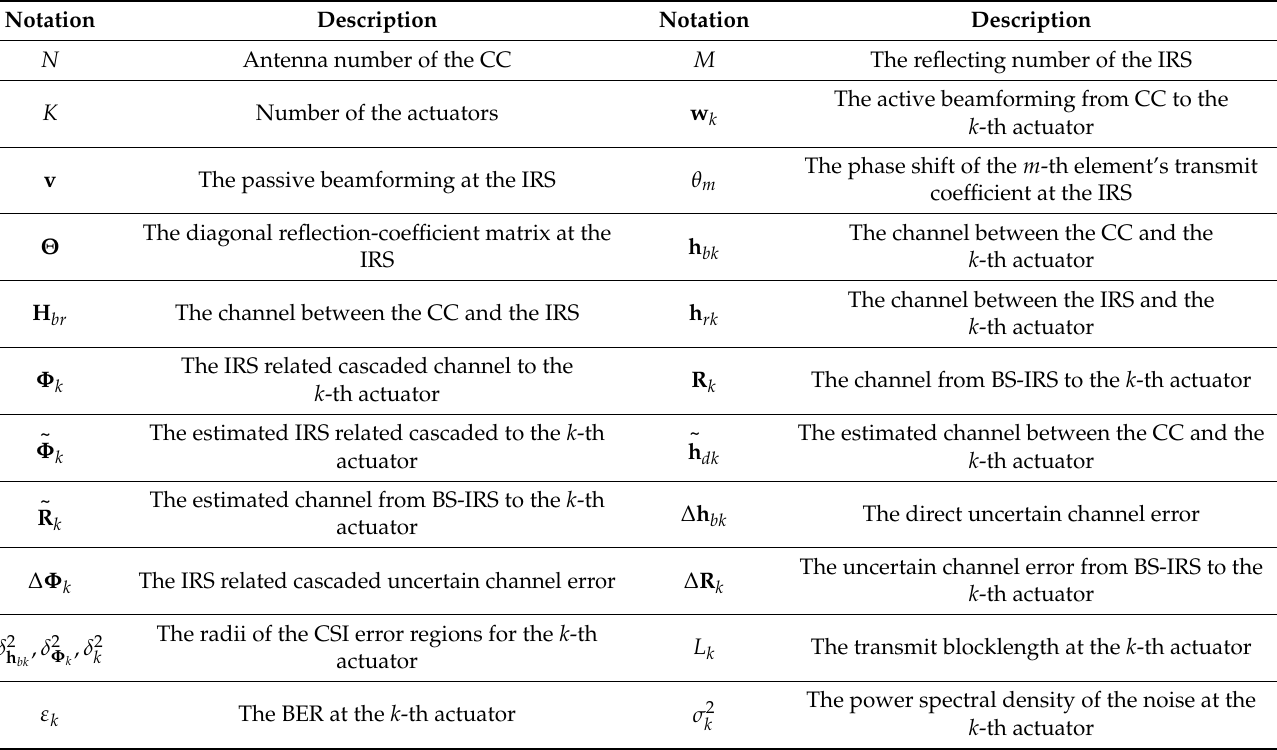
Table A1. List of main